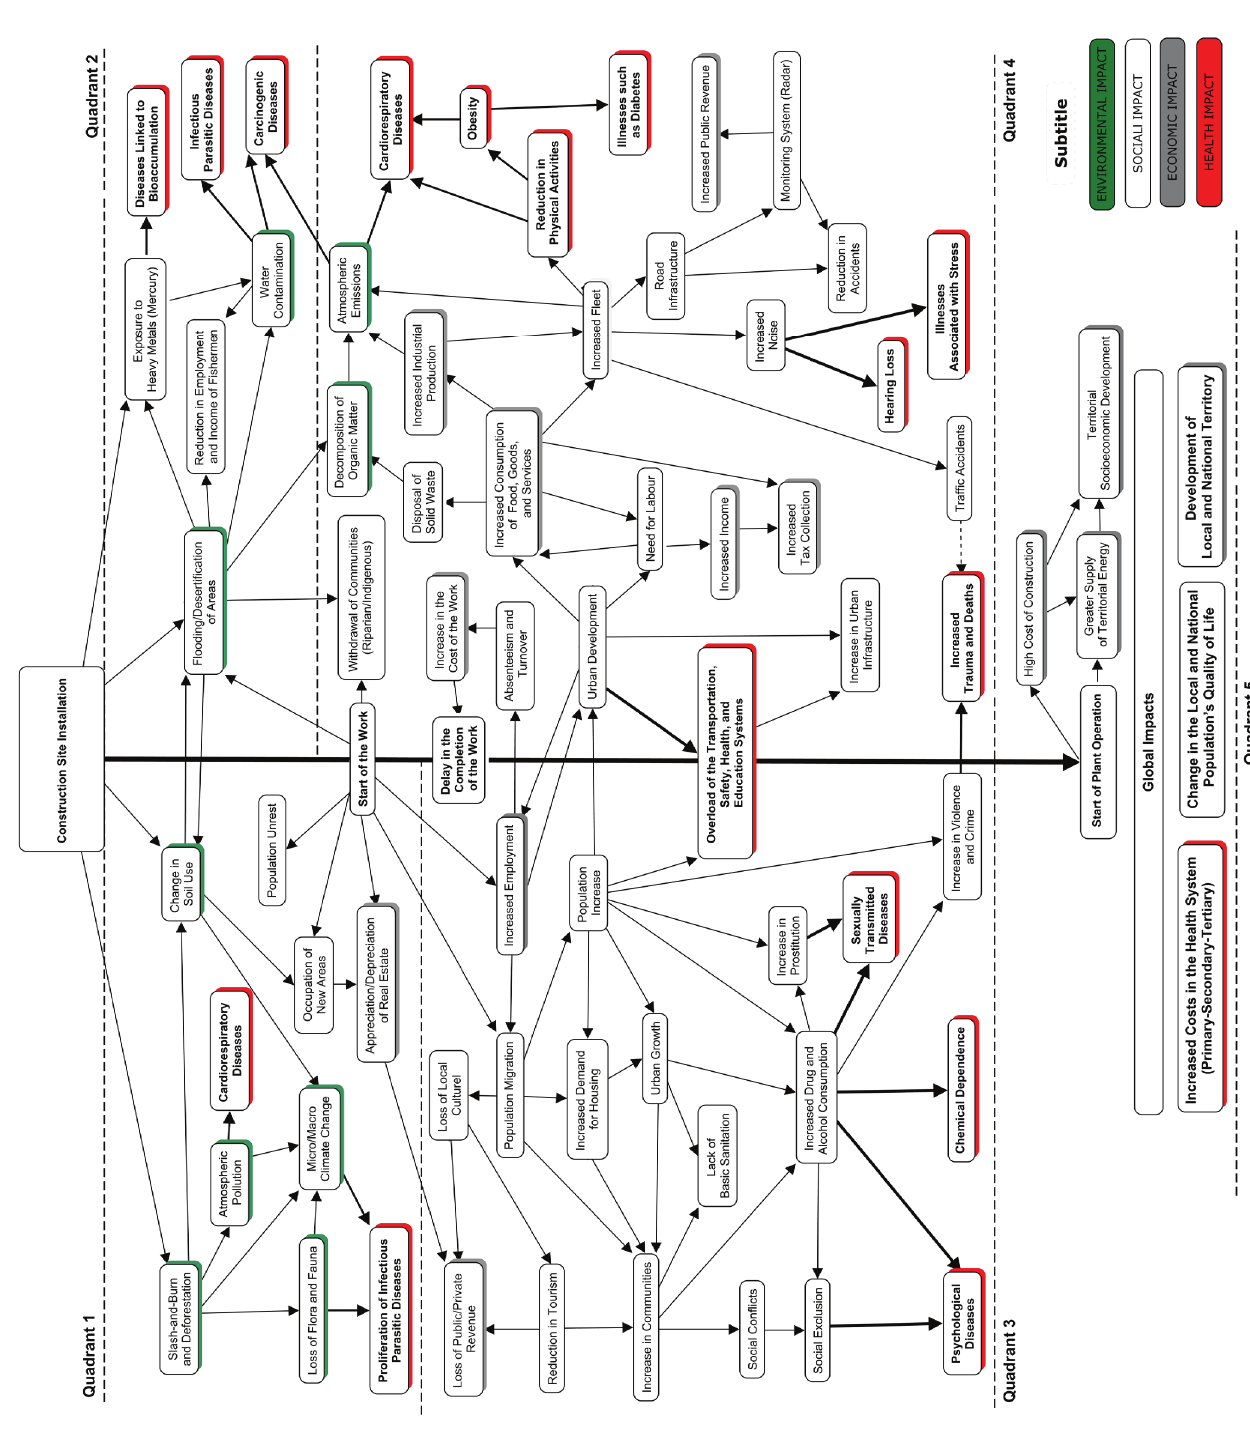
Fig 2. Network of Aspects and